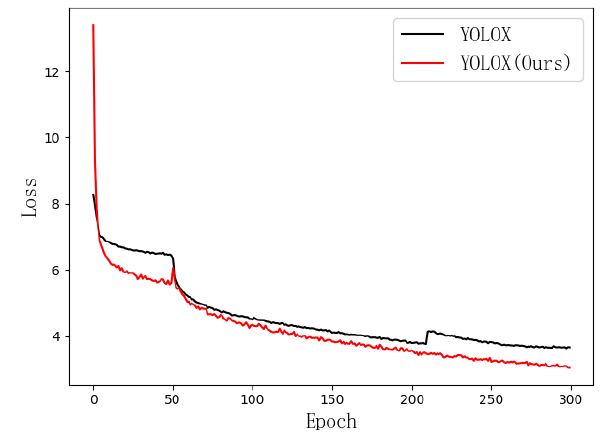
Figure 11. Loss values for training.